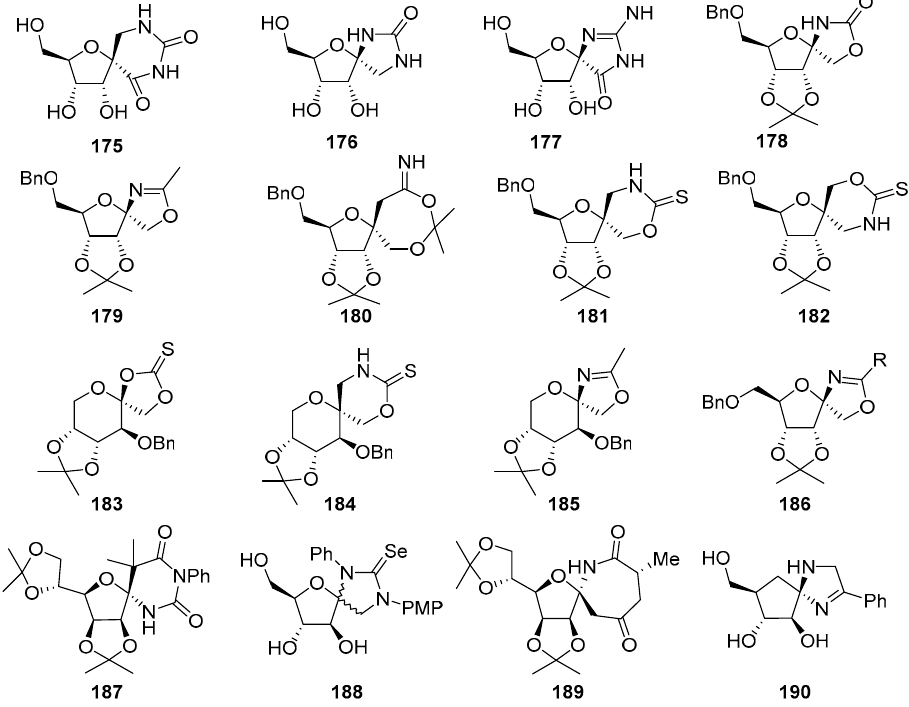
Figure 9. Hydantocidin analogues with miscellaneous spiroheterocyclic rings.